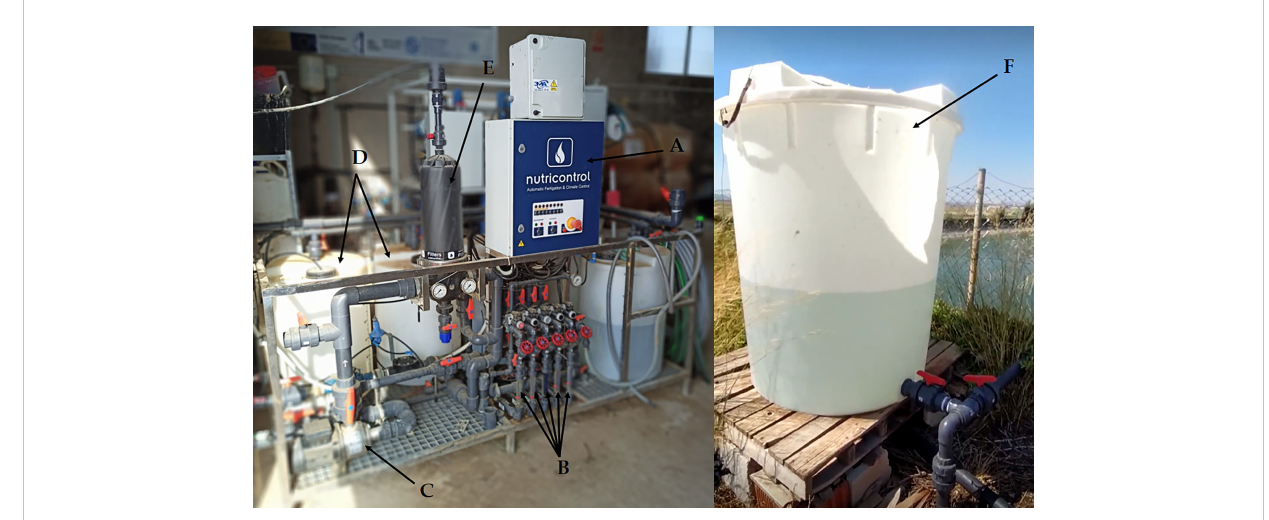
FIGURE 1 Experimental irrigation head. (A) Control panel; (B) fertilizer injectors; (C) feed pump; (D) fertilizer tanks; (E) ring fi lter; (F) sampling